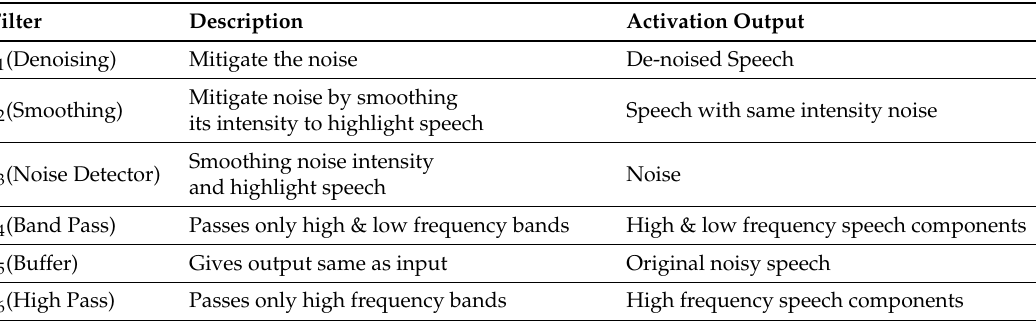
Figure 9. Six spectrograms randomly selected from the hidden layers of network b , explaining the different Convolutional Neural Network (CNN) filters for speech enhancement, for a pro- cessed noisy speech (N) and its clean version (C), f and a represent the convolution filters and activations, respectively. Table 7. Description of CNN filters for the speech enhancement